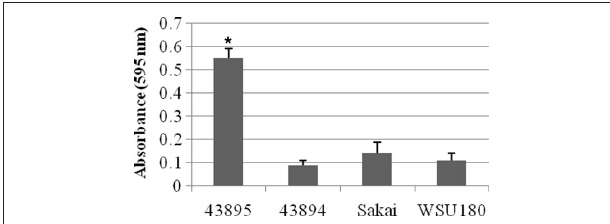
FigUrE 7 | Escherichia coli O157:H7 biofilm formation in crystal violet assays. The E. coli O157:H7 strains indicated were incubated at 37 ° C in MSM containing 4% glucose for 24 h in 96-well microtiter plate under stationary condition. Biofilm formation was measured by the absorbance of solubilized dye in 95% ethanol at 595 nm. The assays were performed six times for each isolate. All values are means and SE. Significant difference is indicated by the asterisk ( P < 0.05).